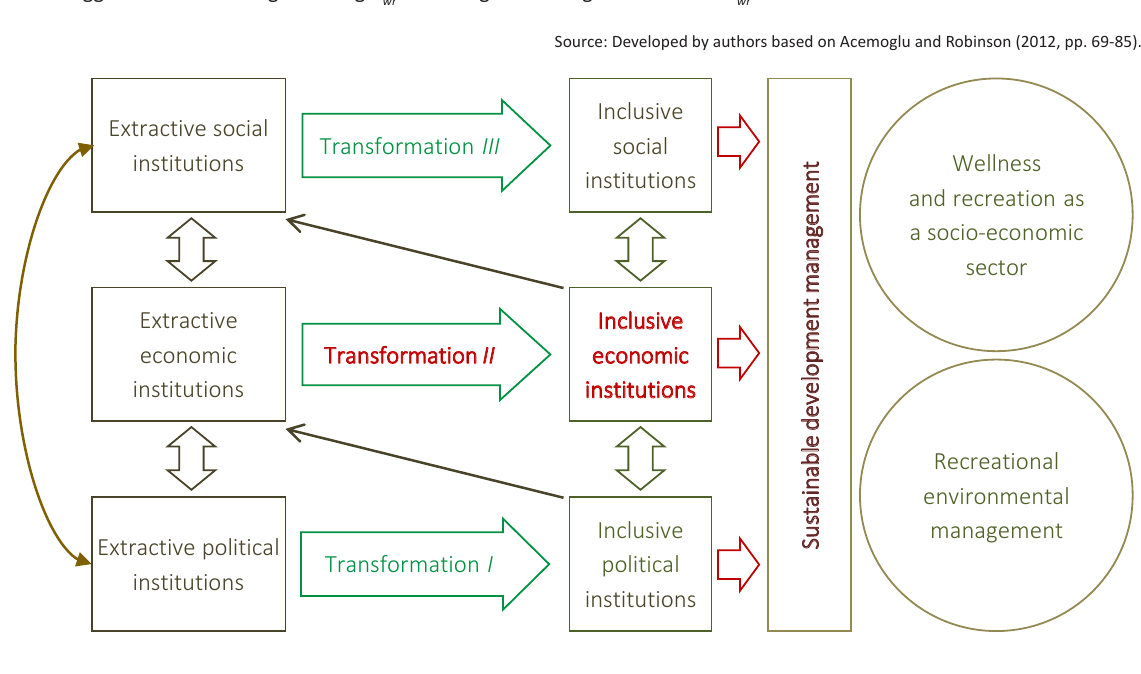
Figure 1. Transformation of extractive institutions into inclusive ones as a prerequisite for wellness and recreation